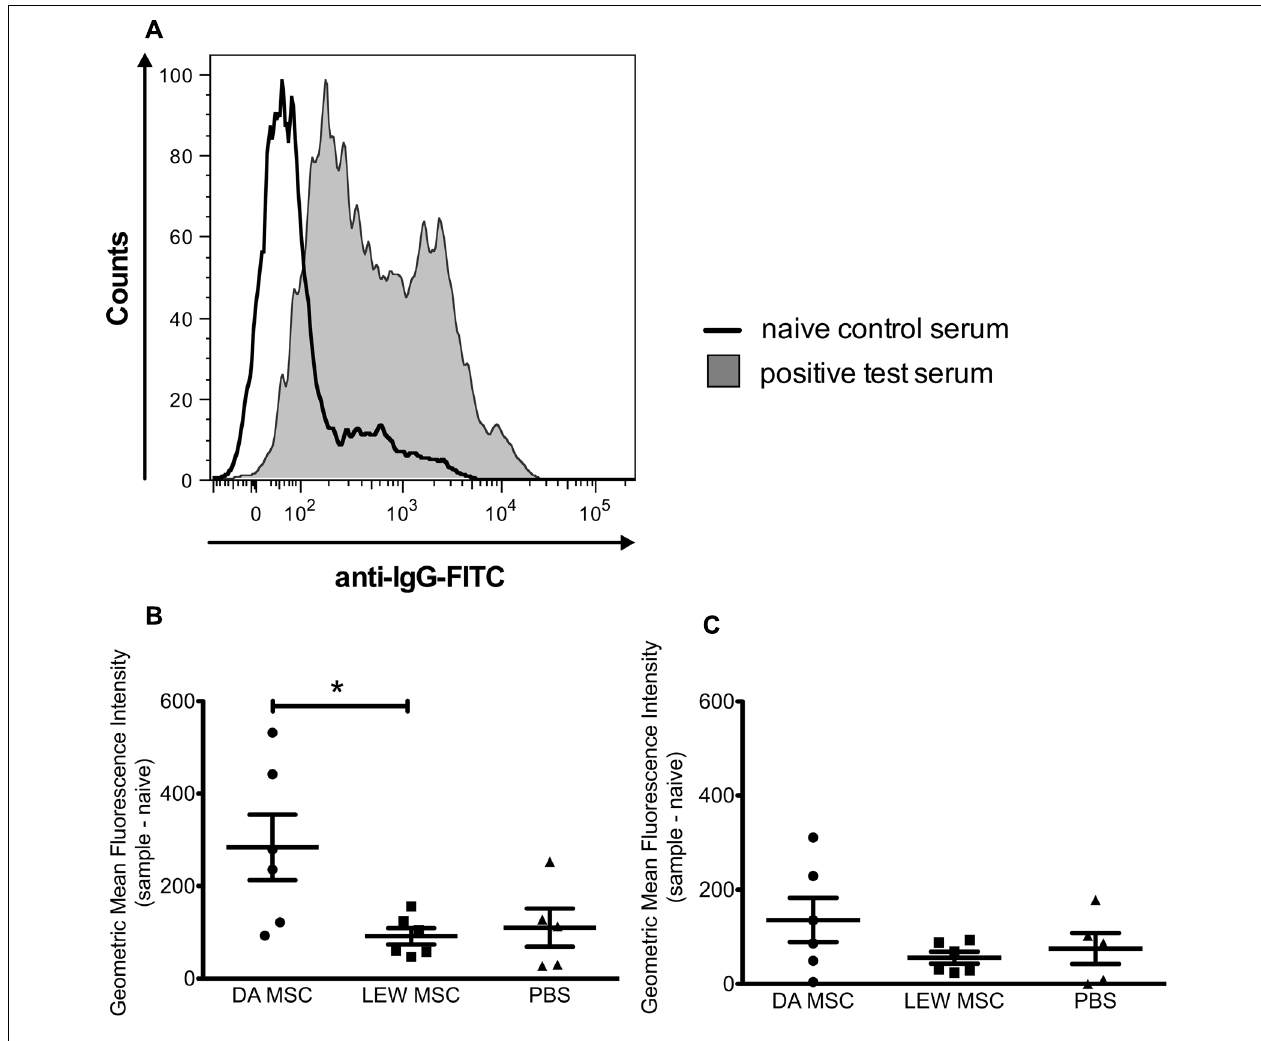
(filled gray curve). Data were collected using a BD FACS Canto II flow cytometer and the geometric MFI was determined. Background values for a naïve animal were subtracted from test rat serum values. Data are presented for (B) IgG and (C) IgM donor-specific antibodies as the mean ± SEM of the geometric MFI from five to six transplanted rats per group; * P <